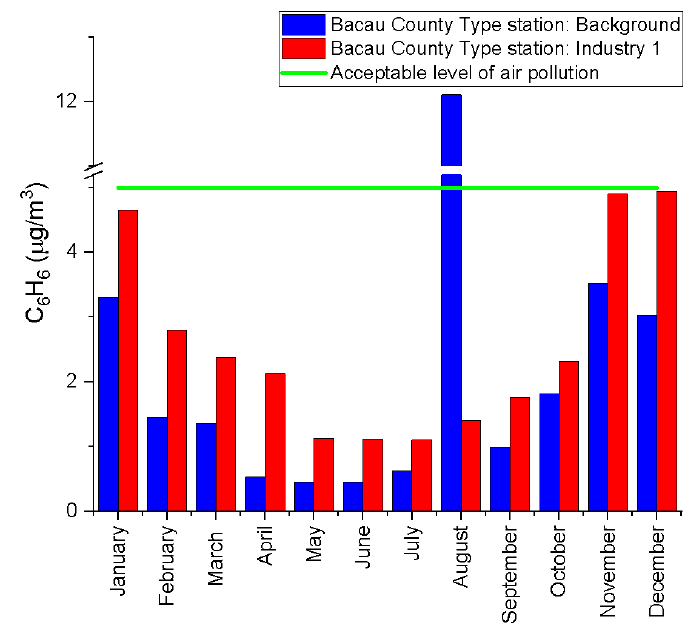
Figure 16. Average C 6 H 6 concentration in individual months of 2020.